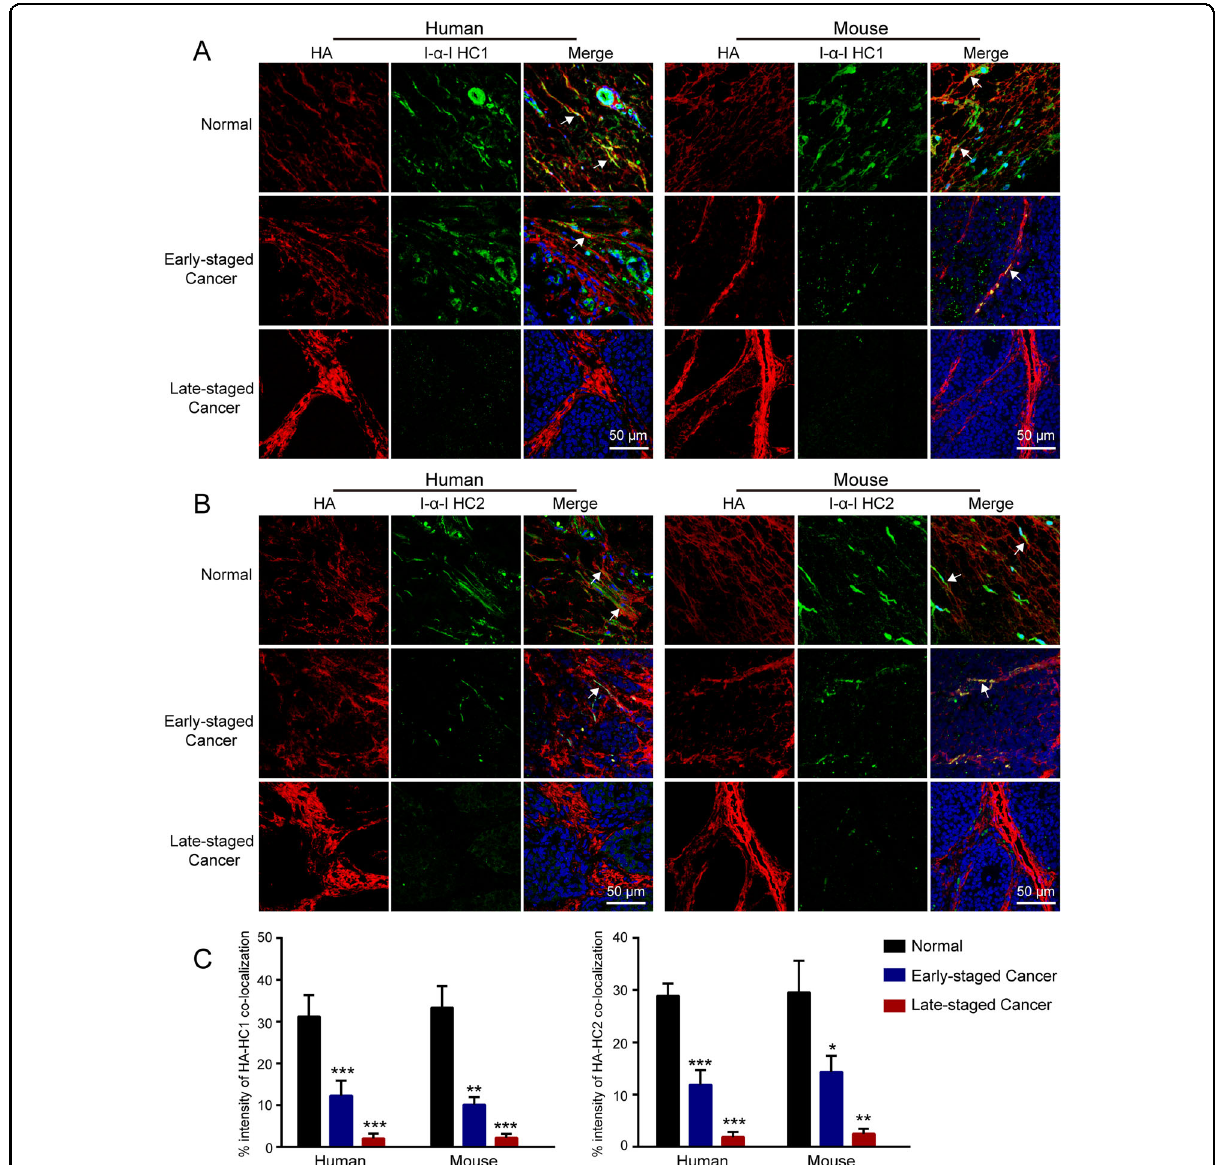
Fig. 1 HA cross-linking was decreased in breast cancer tissues and associated with tumor stage. A Immuno fl uorescence staining of HA (red) and I- α -I HC1 (green) in cancer tissues and corresponding adjacent normal tissues from patients with early (stage I, n = 7) or late (stage III, n = 9) staged breast cancer, normal mammary gland tissues from FVB mice, and cancer tissues from MMTV-PyMT mice with early (week 10) or late (week 16) staged breast cancer. B Immuno fl uorescence staining of HA (red) and I- α -I HC2 (green) in corresponding tissues. The white arrowheads refer to the co-localization of HA and I- α -I, which means HA cross-linking. HA and I- α -I HCs were both localized within and outside of cells. C The intensity ratio of HA co-localized with I- α -I HCs to total HA was used to determine the levels of HA-HC complexes. The intensity percentage of HA-HCs co-localization was acquired by the Image J software. Error bars show mean ± SD values. Statistical analysis was performed using Student ’ s t test. * p < 0.05, ** p < 0.01, *** p <